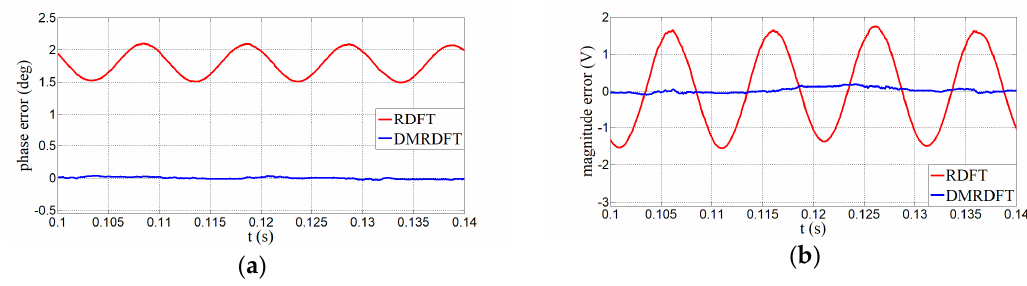
Figure 15. The contrast of RDFT and DMRDFT performance with the noise: ( a ) phase error, and ( b ) magnitude error.